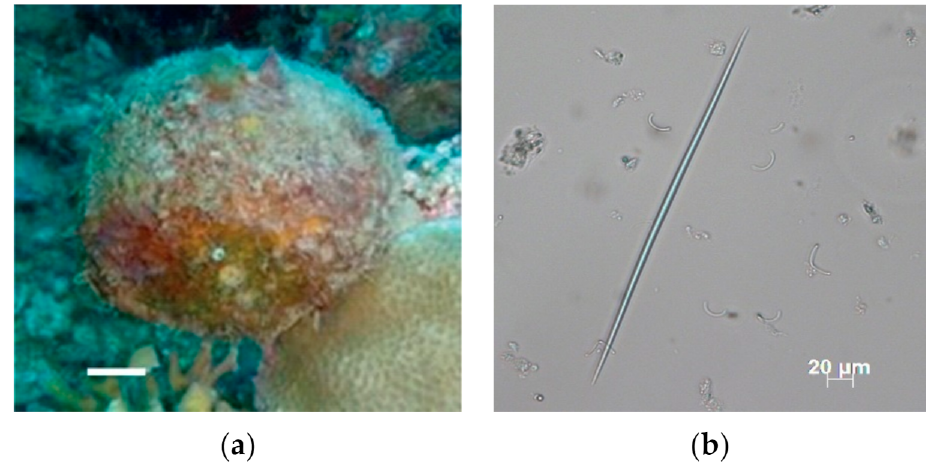
Figure 2. ( a ) Sponge 18A13 bar 3 cm, ( b ) spicule of the same specimen.